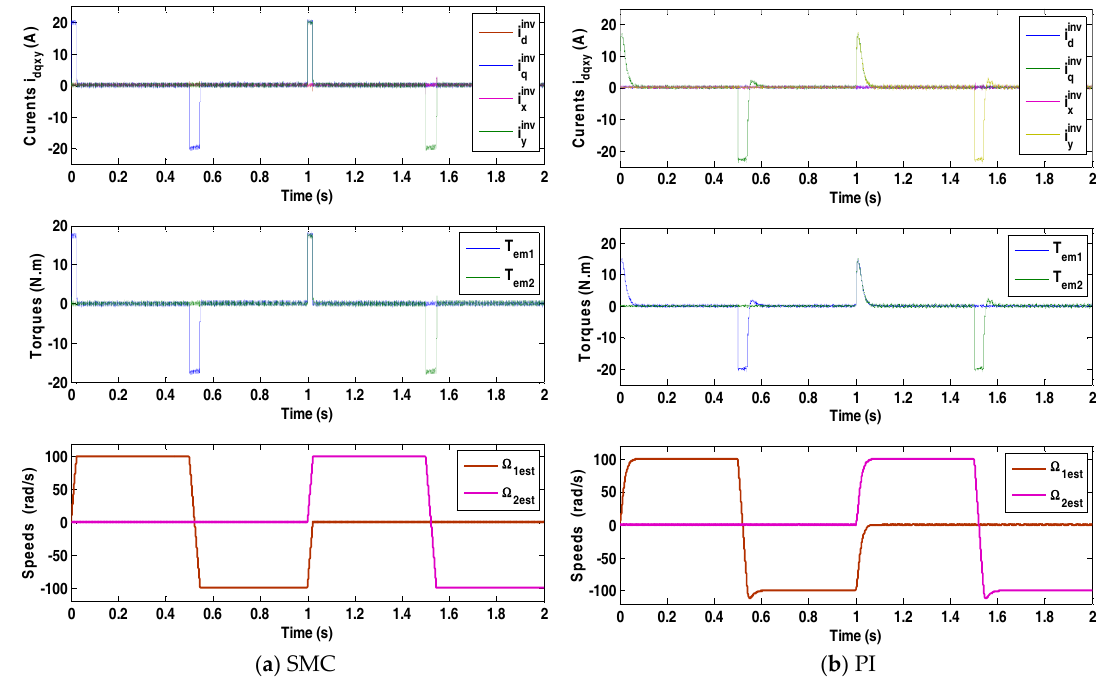
Figure 9. Dynamic responses of parallel-connected two five-phase PMSMs system: when one machine is at standstill and the other is still running. Electronics 2018 , 7 , x FOR PEER REVIEW 16 of 19